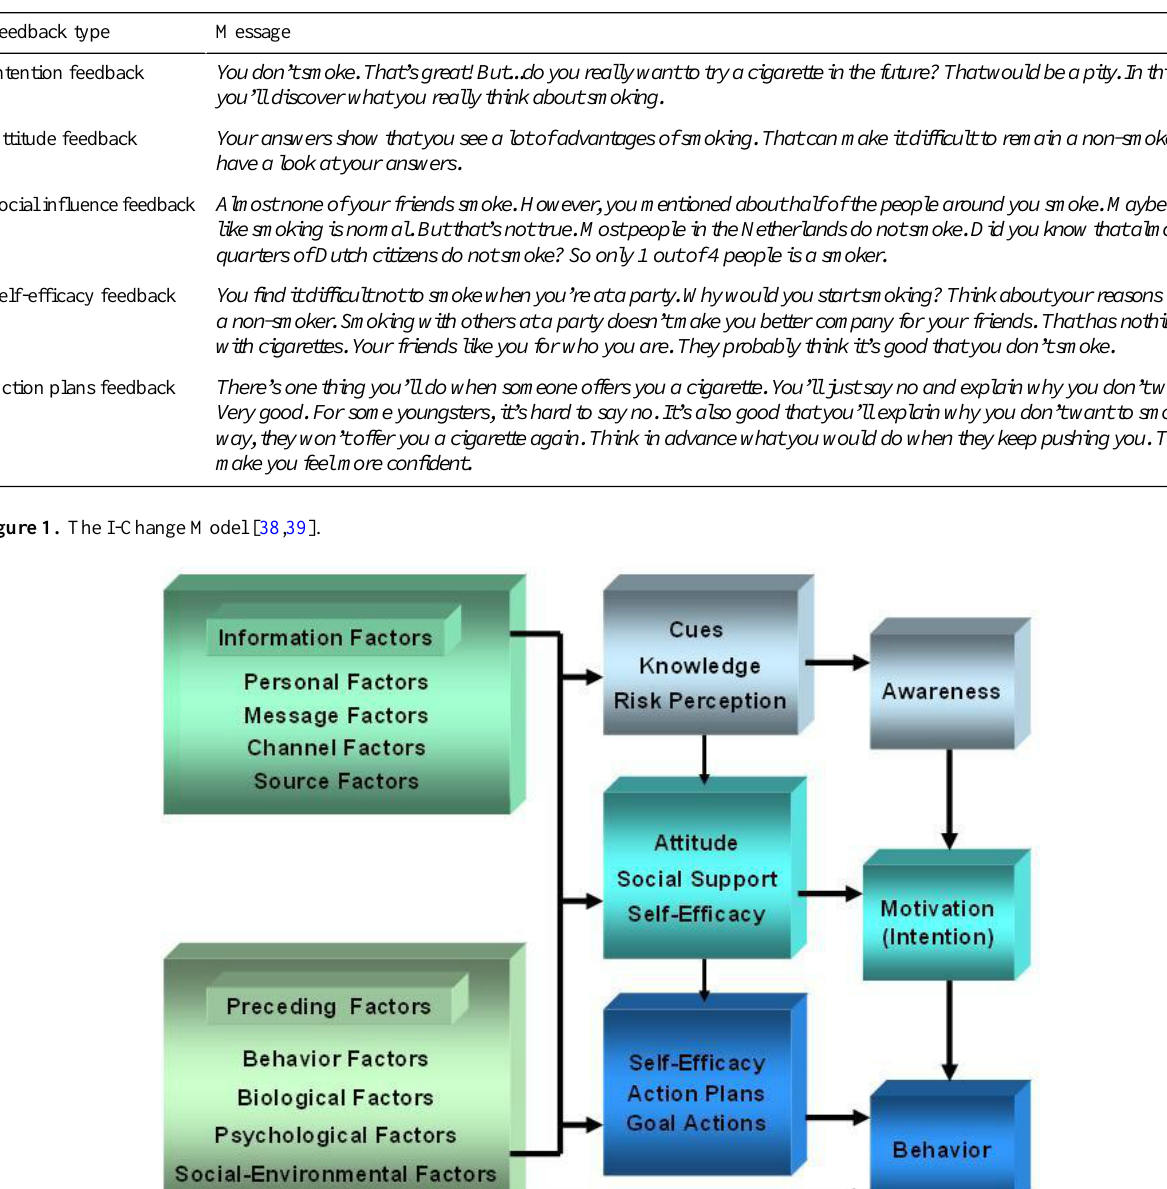
Table 1. Examples of feedback messages [36].